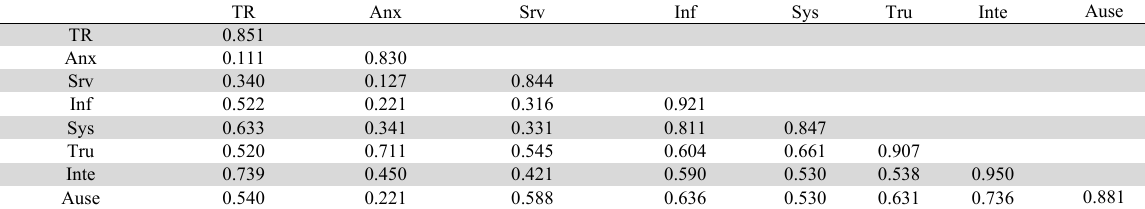
The Fornell-Larcker Discriminant Validity Correlation Matrix